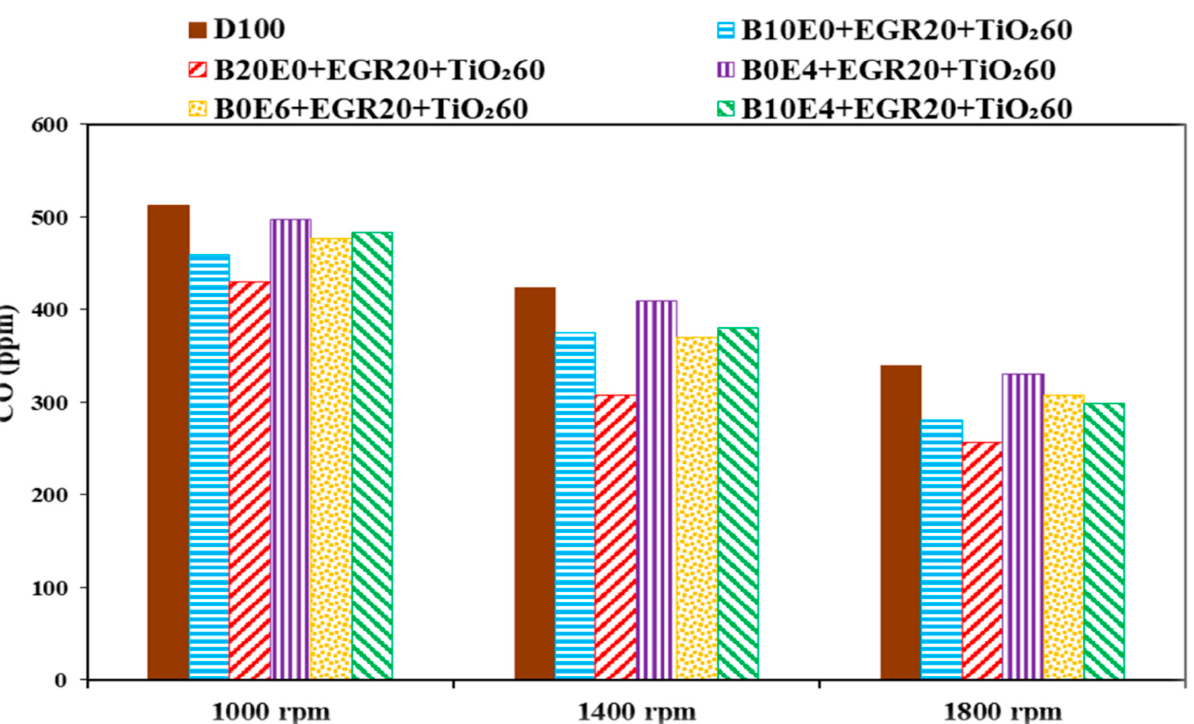
Figure 13. Variation of CO for diesel/ethanol/biodiesel blends at EGR = 20%, TiO 2 = 60 ppm, and various engine speeds.